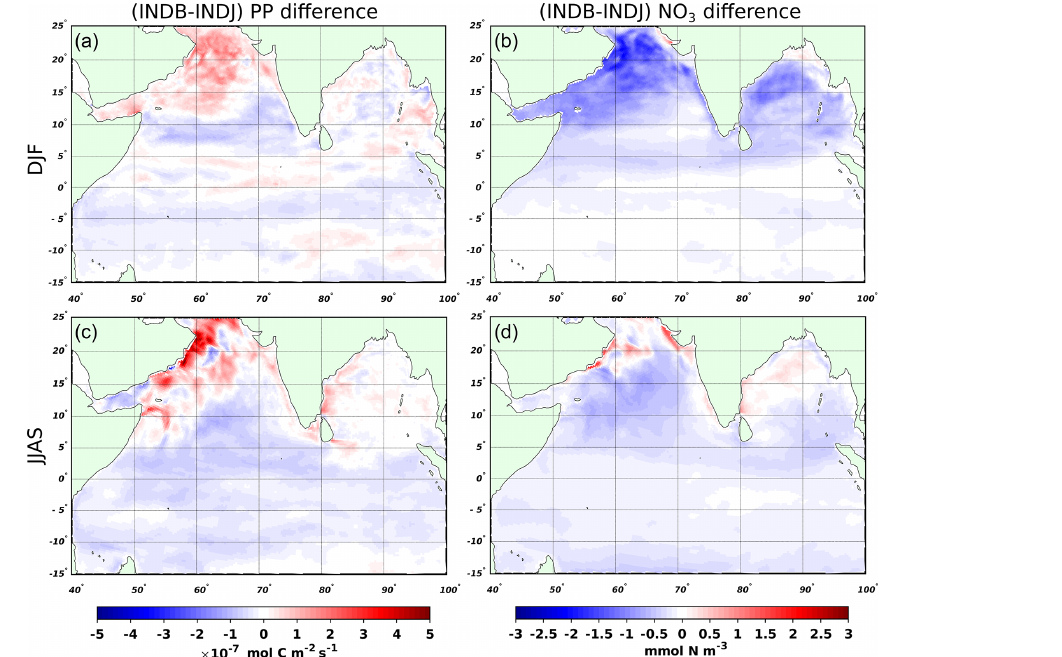
Figure 11. Spatial distribution of the difference between the model runs (INDB–INDJ) for PP ( a , c ) and NO 3 ( b , d ). PP and NO 3 are time-averaged seasonally (DJF, JJAS) for the period